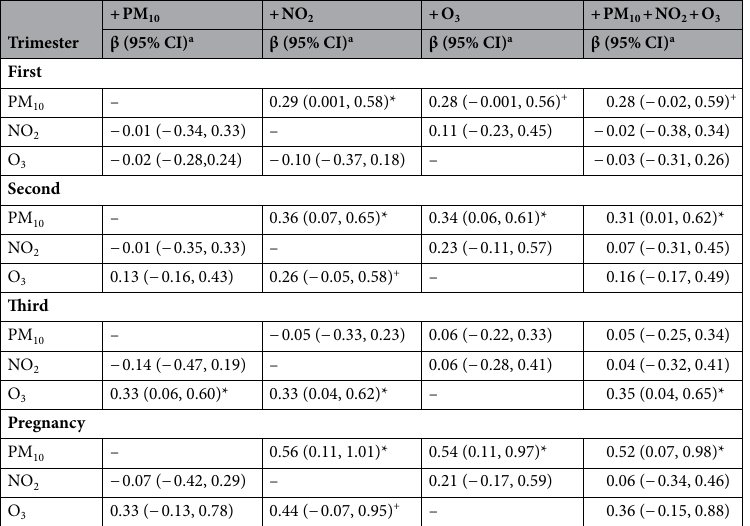
Table 4. Multi-pollutant model of associations between exposure to air pollutants (per IQR increase) and PSS scores among pregnant women. + p-value < 0.1. *p-value < 0.05. a Multi-pollutant model was further adjusted for the effects of other air pollutants in the same time window using the adjusted single-pollutant model 4 shown in Table